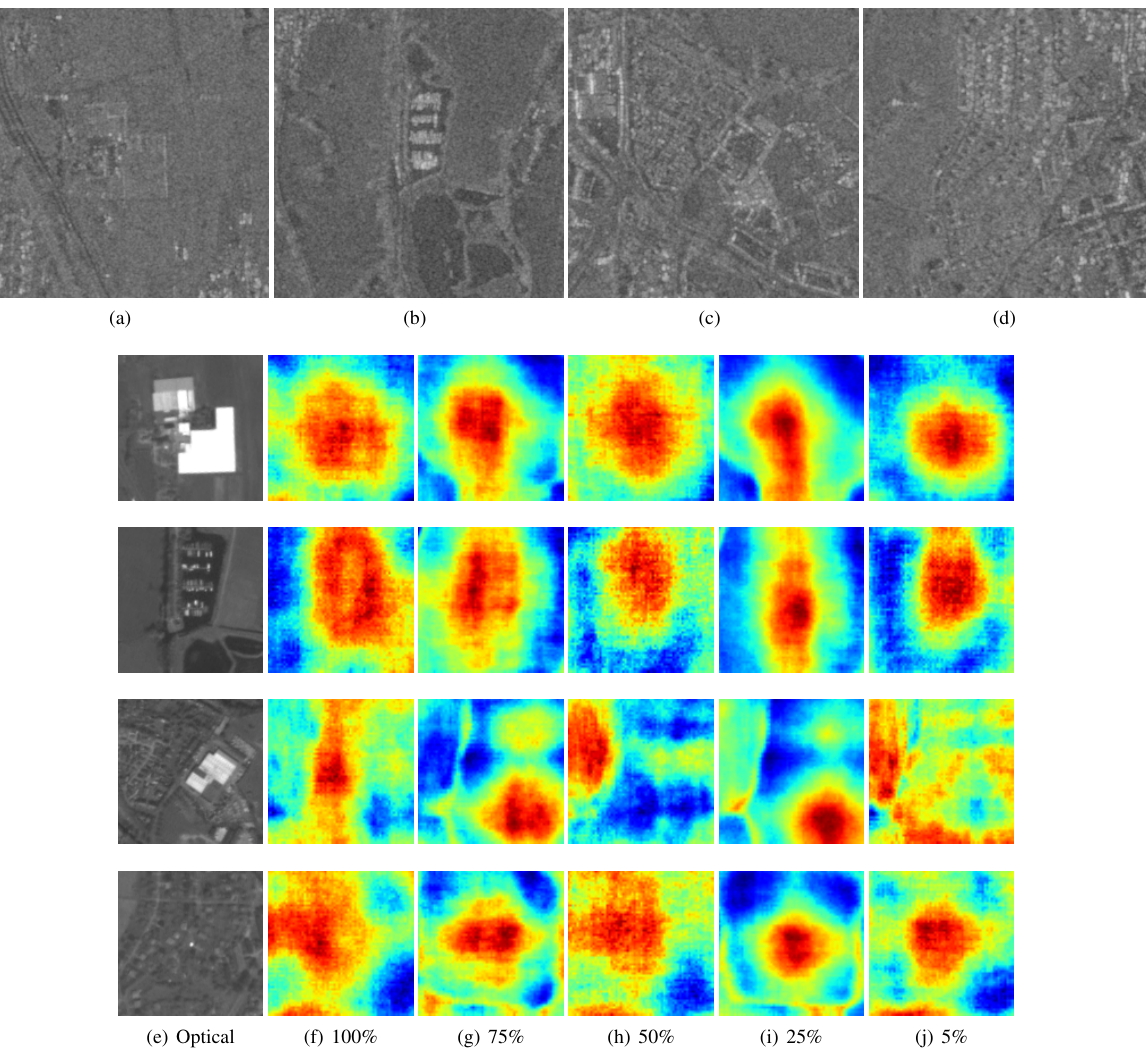
Figure 5: Correspondence maps produced under varying conditions of data scarcity, on example scenes of differing density. ( a-d ) exemplary SAR test scenes, corresponding rows depicting ( e ) optical image patch, an d (f - j) co rrespondence maps when trained with supervision percentage of 100%, 75%, 50%, 25% and 5%